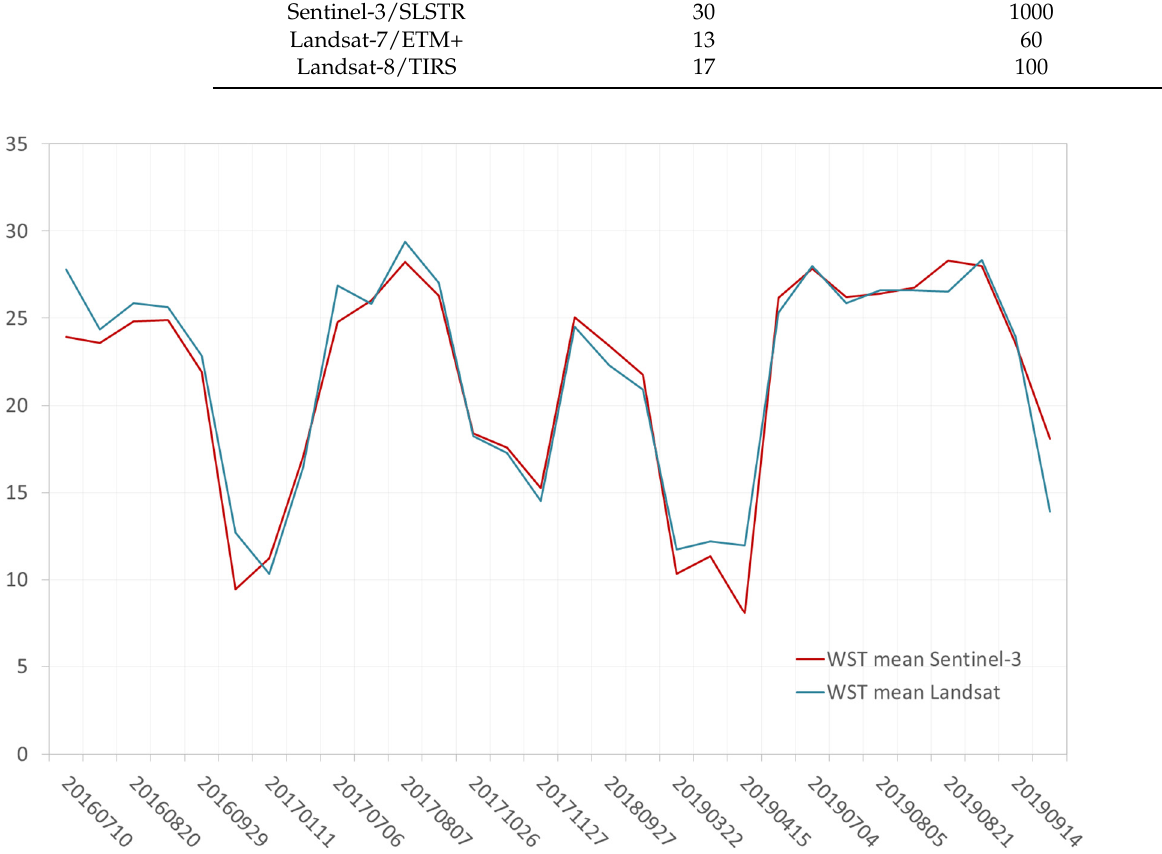
Figure 9. Comparison between the WST derived from Landsat and Sentinel-3 SLSTR Level-2 WST products of the same day.